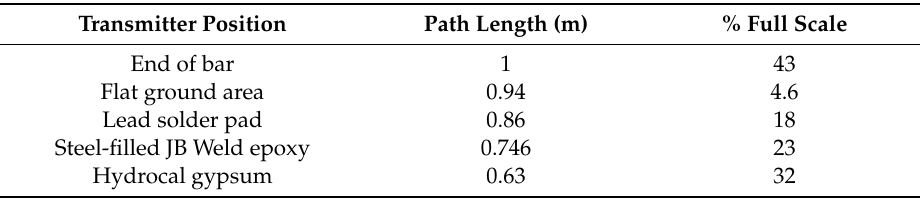
Table 2. Results of Specimen Set 3a